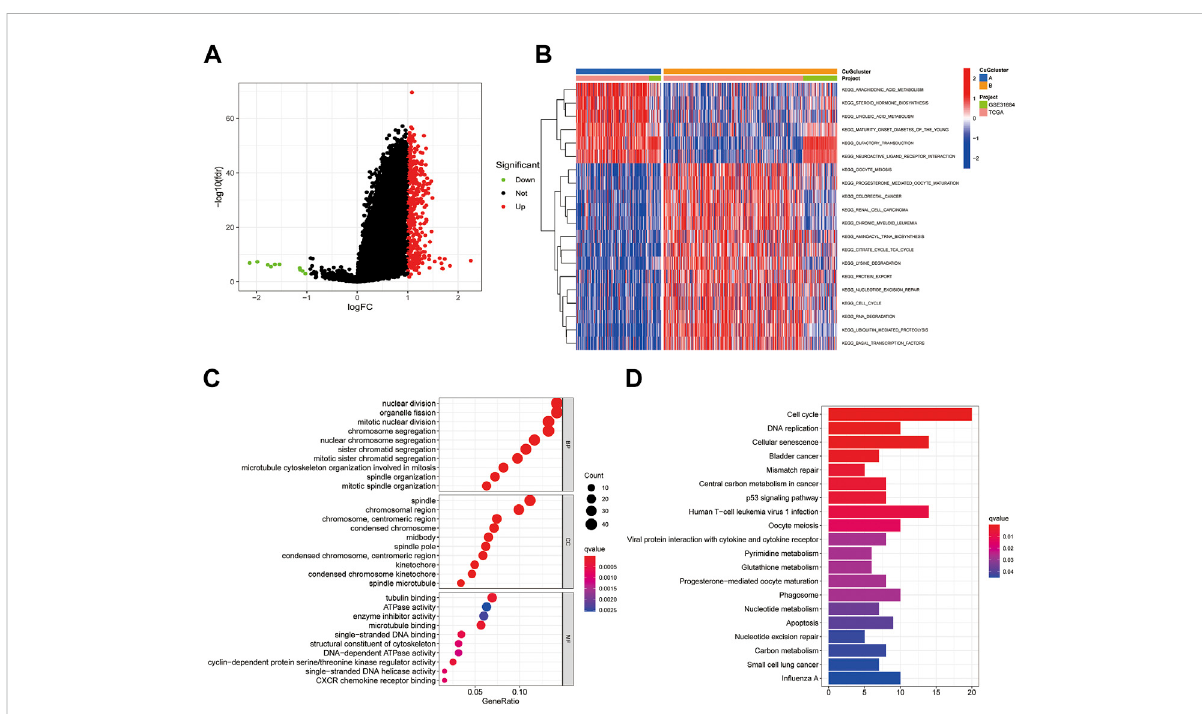
FIGURE 3 Enrichment analysis of differential genes between cuproptosis-related molecular patterns. (A) Volcano plot showed the differential genes between cuproptosis-related molecular patterns. Up-regulated genes in pattern B were shown in red and down-regulated genes were shown in green. Genes of no signi fi cance were shown in black. (B) GSVA enrichment analysis of the differential genes. (C) GO enrichment analysis of BP, CC, and MF results ranked by gene ratio. (D) KEGG pathway analysis of the differential genes. Abbreviations: GSVA, gene set variation analysis; GO, gene ontology; BP, biological process; CC, cellular component; MF, molecular function; KEGG, kyoto encyclopedia of genes and